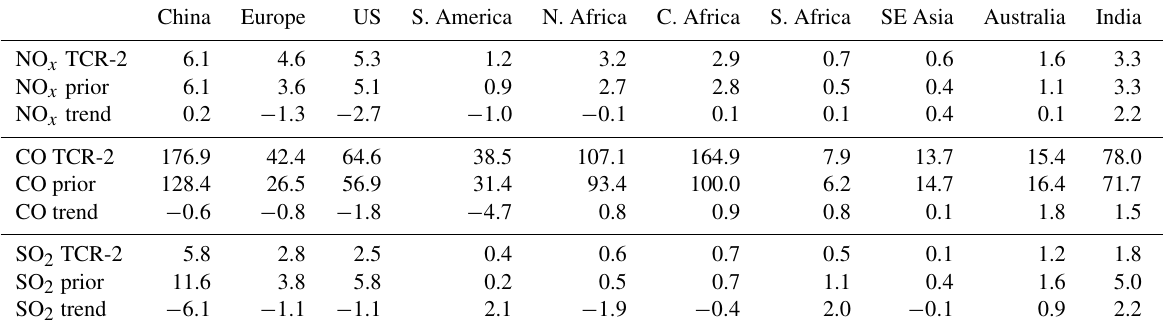
Table 8. The regional mean surface NO x (in TgNyr − 1 ), CO (in TgCOyr − 1 ), and SO 2 emissions (in TgSyr − 1 ) obtained from the a priori emissions and a posteriori emissions for the period 2005–2018 and their linear trends (in % per year). The results are shown for China